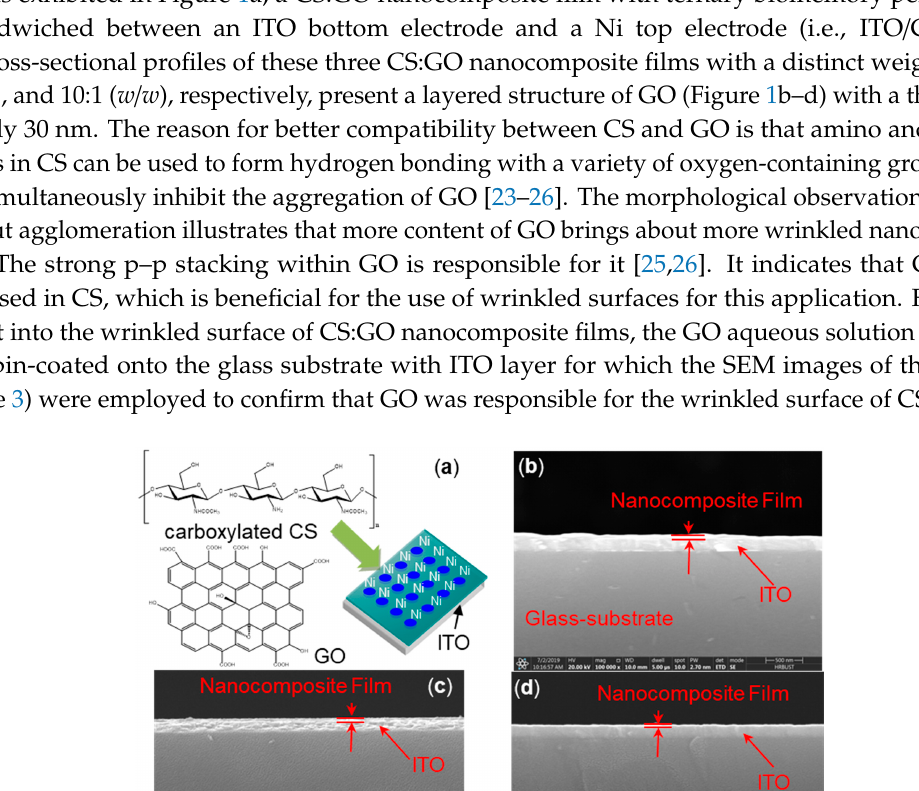
Figure 2. Scanning electron microscopy (SEM) images of the morphology for CS:GO nanocomposite films with the chemical component ratio ( a – c ) 2:1, ( d – f ) 5:1, and ( g – i ) 10:1 w/w, respectively, in terms of distinct magnification 10,000×, 40,000×, and 100,000×, respectively. (HV: 20 kV, WD: 10.4 mm, dWell: 5 μ s).